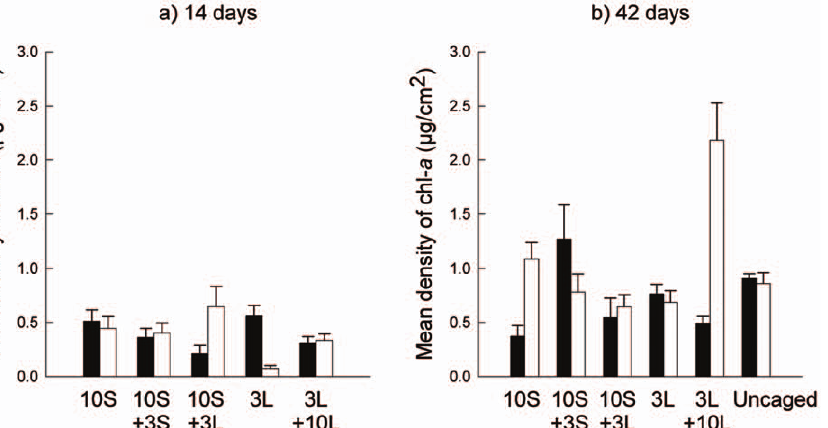
Figure 5. Chlorophyll- a densities for each treatment. Mean ( 6 SE; n =10) density of chlorophyll- a (mug/cm 2 ) in plots with (white bars) or without (black bars) macroalgae 14 days (a) or 42 days (b) after the start of the experiment. S, small limpets; L, large